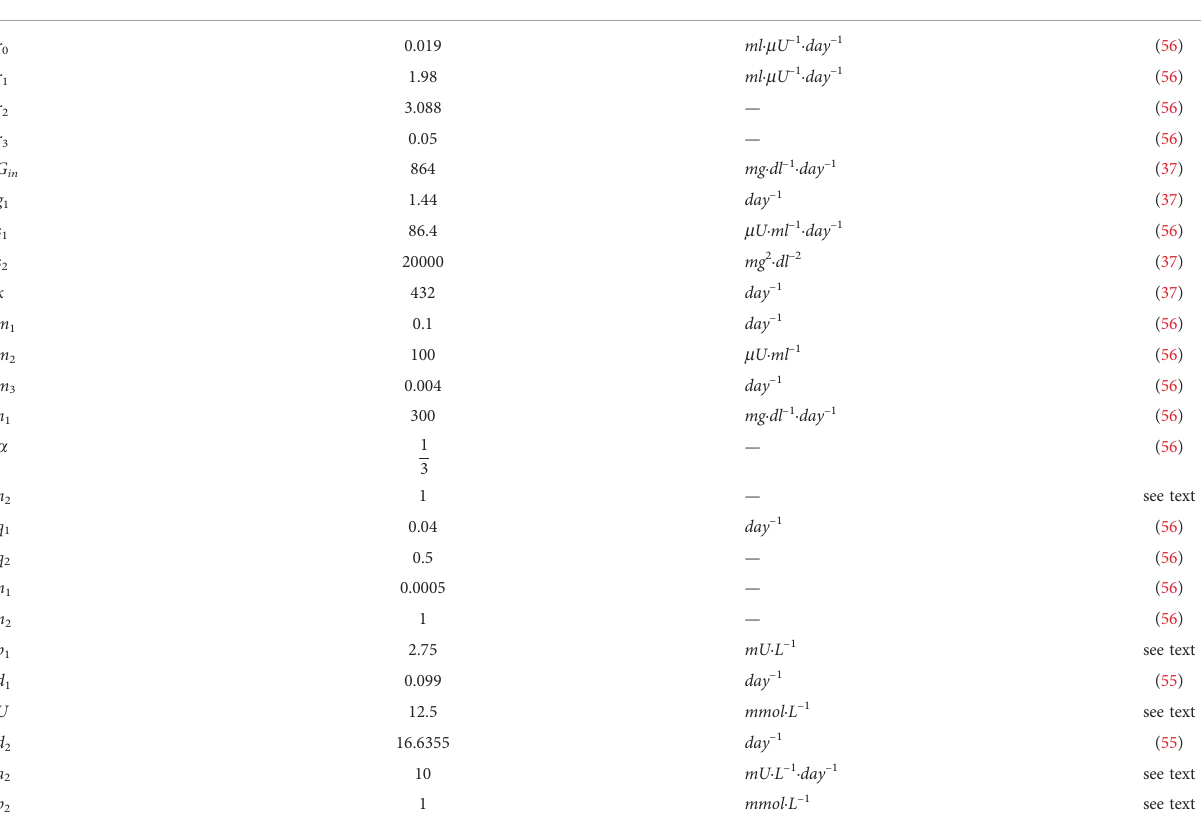
TABLE 1 Parameter values for the hyperthyriod-diabetes progression model.